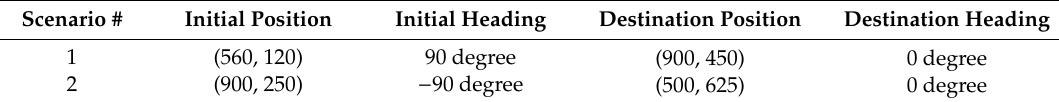
Figure 17. The map of lab pre-built by the robot. Table 2. Robot’s task for each